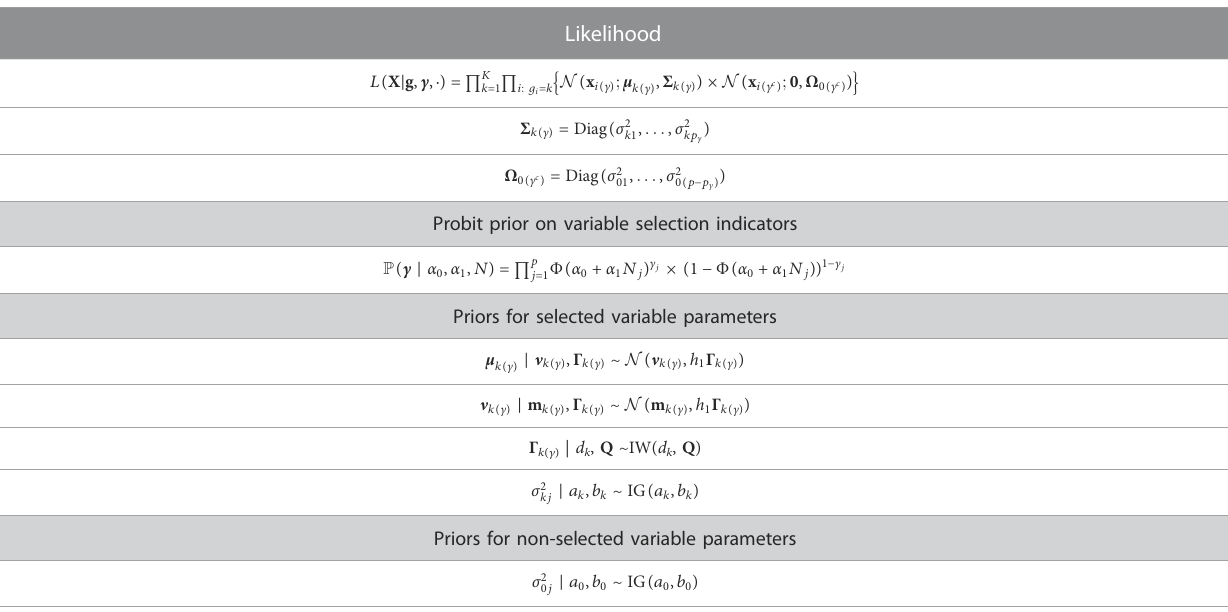
TABLE 1 A summary of the RVS model speci fi cation.